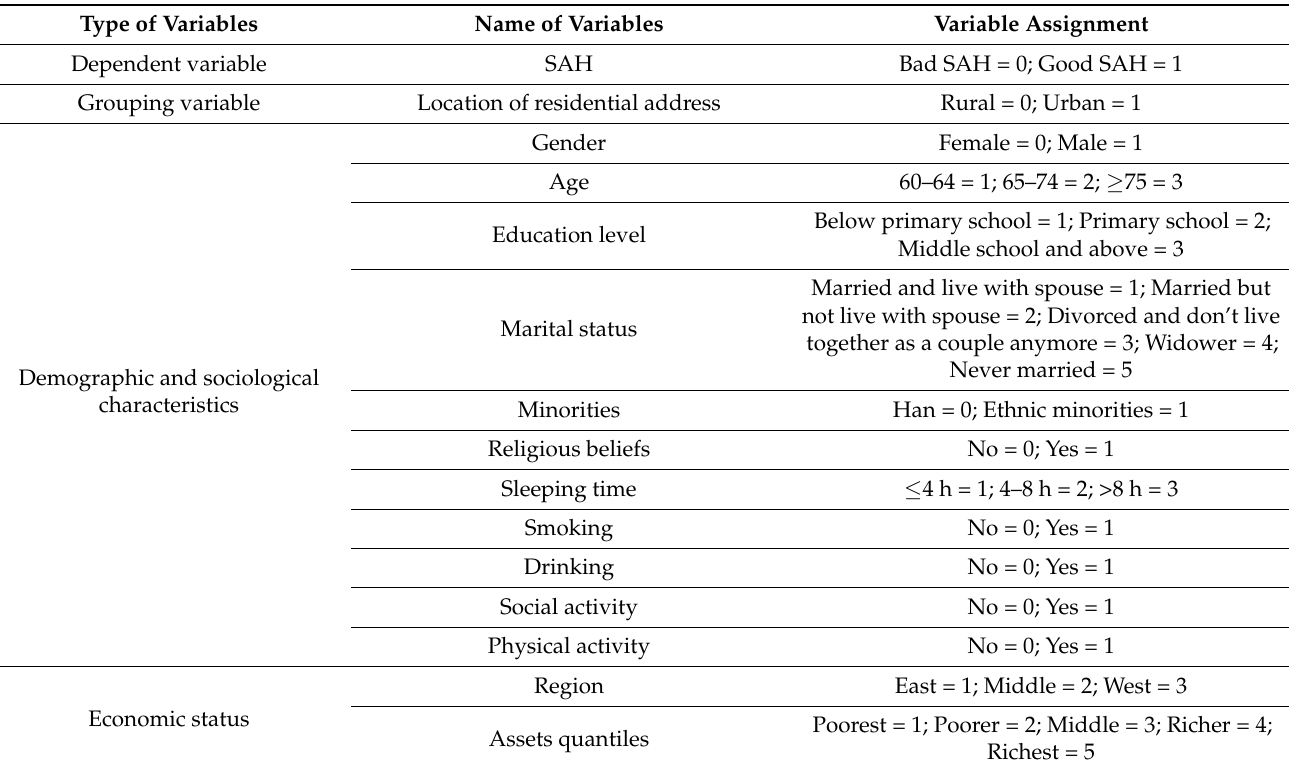
Table 1. Definition and measurement of